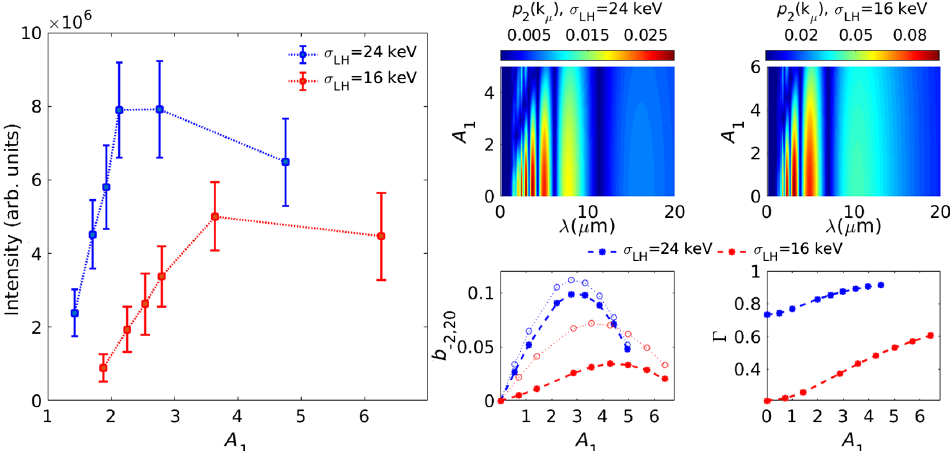
FIG. 5. Left: FEL intensity vs first seed laser pulse energy. Blue and red lines are experimental data for LH-induced energy spread σ ¼ 24 keV and σ ¼ 16 keV. Right-top row: beam energy modulation amplitude as function of the (compressed) MBI modulation LH LH wavelength and first seed coherent energy modulation amplitude (seed energy), at the exit of the second modulator. Right-bottom row: bunching factor and product function vs first seed coherent energy modulation amplitude. Dotted lines with circles show lines with stars show b − 2 ; 20 in Eq. (11). The two subplots refer to the LH inducing 24 keVand 16 keV rms energy spread,